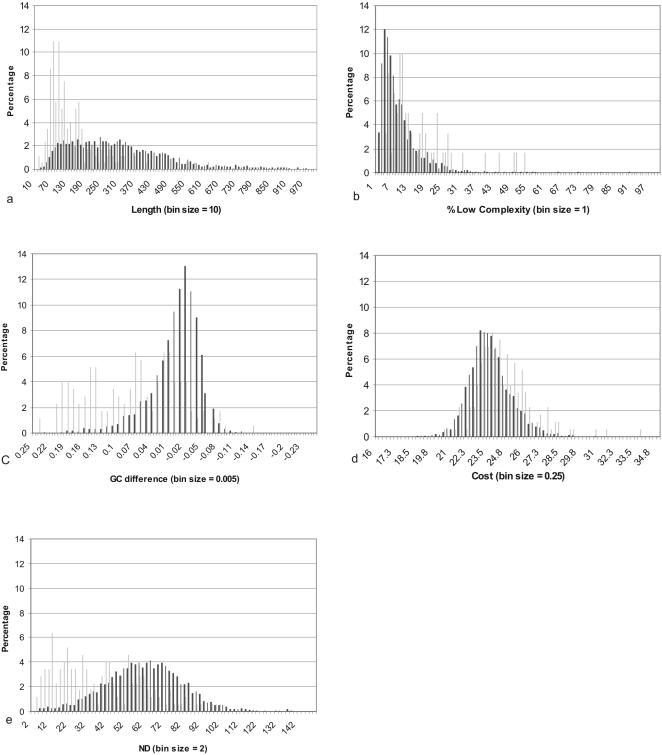
Distributions of orphans and non-orphans in E.coli K12.The predicted proteins in E.coli K12 that were found to be unique (light gray) when compared to 122 bacterial proteomes (shown in Table S1) were designated as orphans (n = 174). All remaining proteins (dark gray) were non-orphans (n = 4137). Distributions of values for both groups were calculated as a percentage for (a) length, (b) percent low complexity, (c) G+C difference from the mean, (d) Cost and (e) Neighbourhood Distribution.